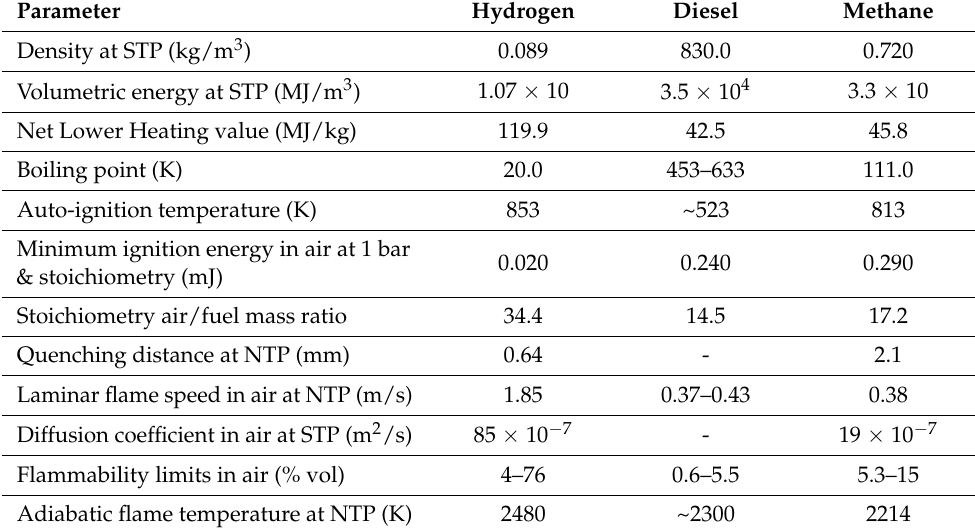
Table 1. The main technical characteristics of hydrogen vs. other fuels